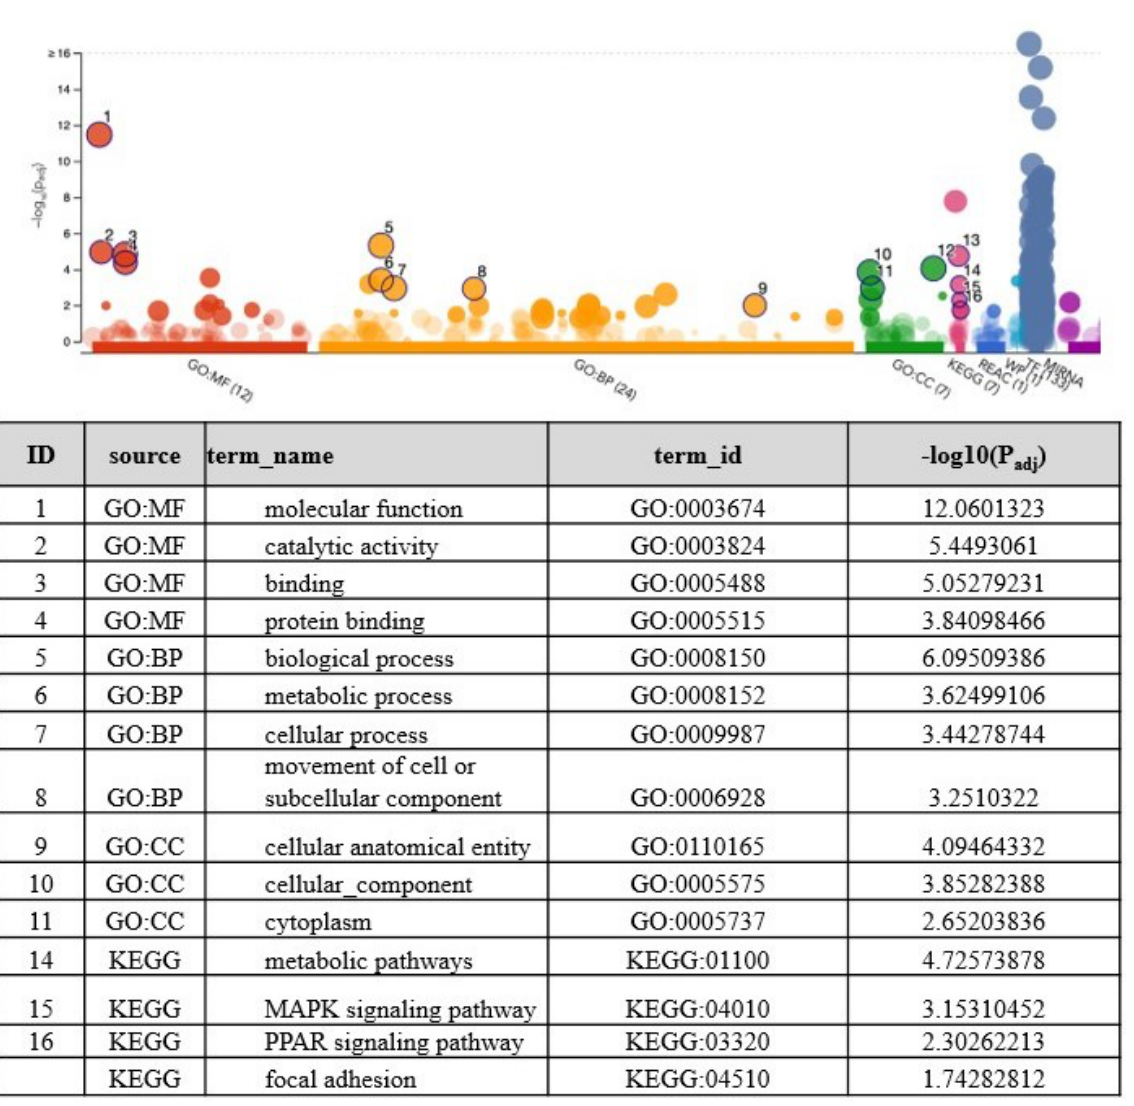
Figure 3. Manhattan plot created with g: GOSt in g: Profiler that illustrates enrichment of gene ontology (GO) terms associated with DEGs between 0- and 2-mM metformin-treated COVCAR cells: the x-axis represents functional terms that are grouped and color-coded. From GO: molecular function (MF), biological process (BP), cellular components (CC), and KEGG pathways. The color intensity denotes the significance of GO terms. The y-axis shows the adjusted enrichment p values in − log10 (Padj). The table under the Manhattan plot identifies the top GO terms associated with MF, BP, CC, and KEEG pathways and are numbered by − log10 (Padj)